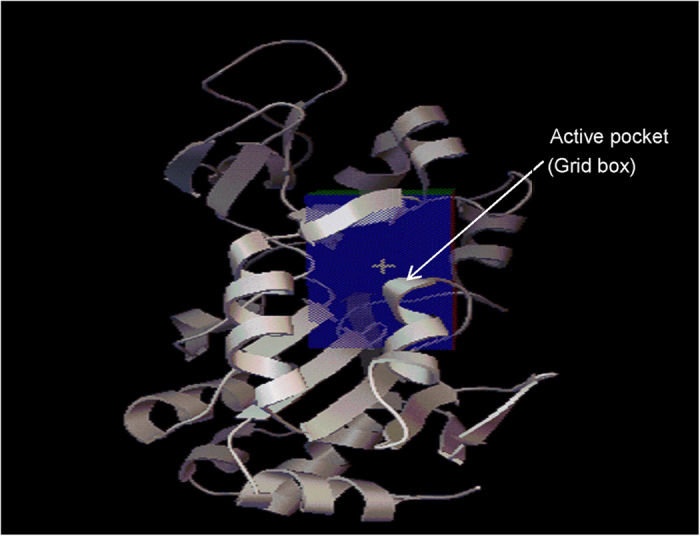
SIRT1 active pocket.